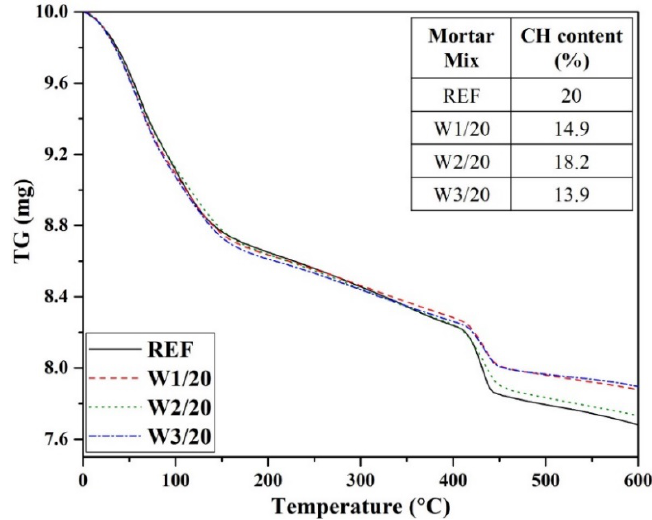
Figure 6. TG curves and calcium hydroxide content of paste specimens at 28 days.